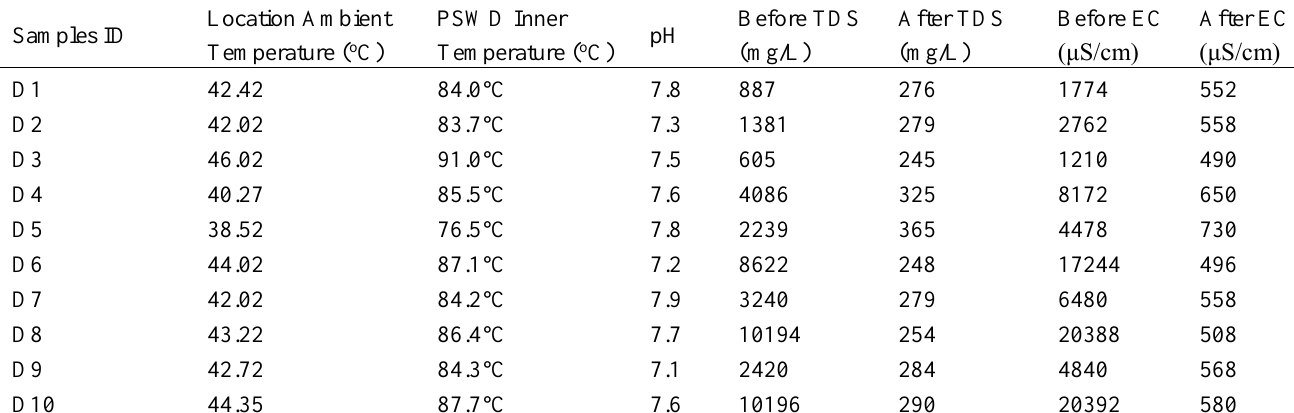
Results of Diplo water samples before and after treatment